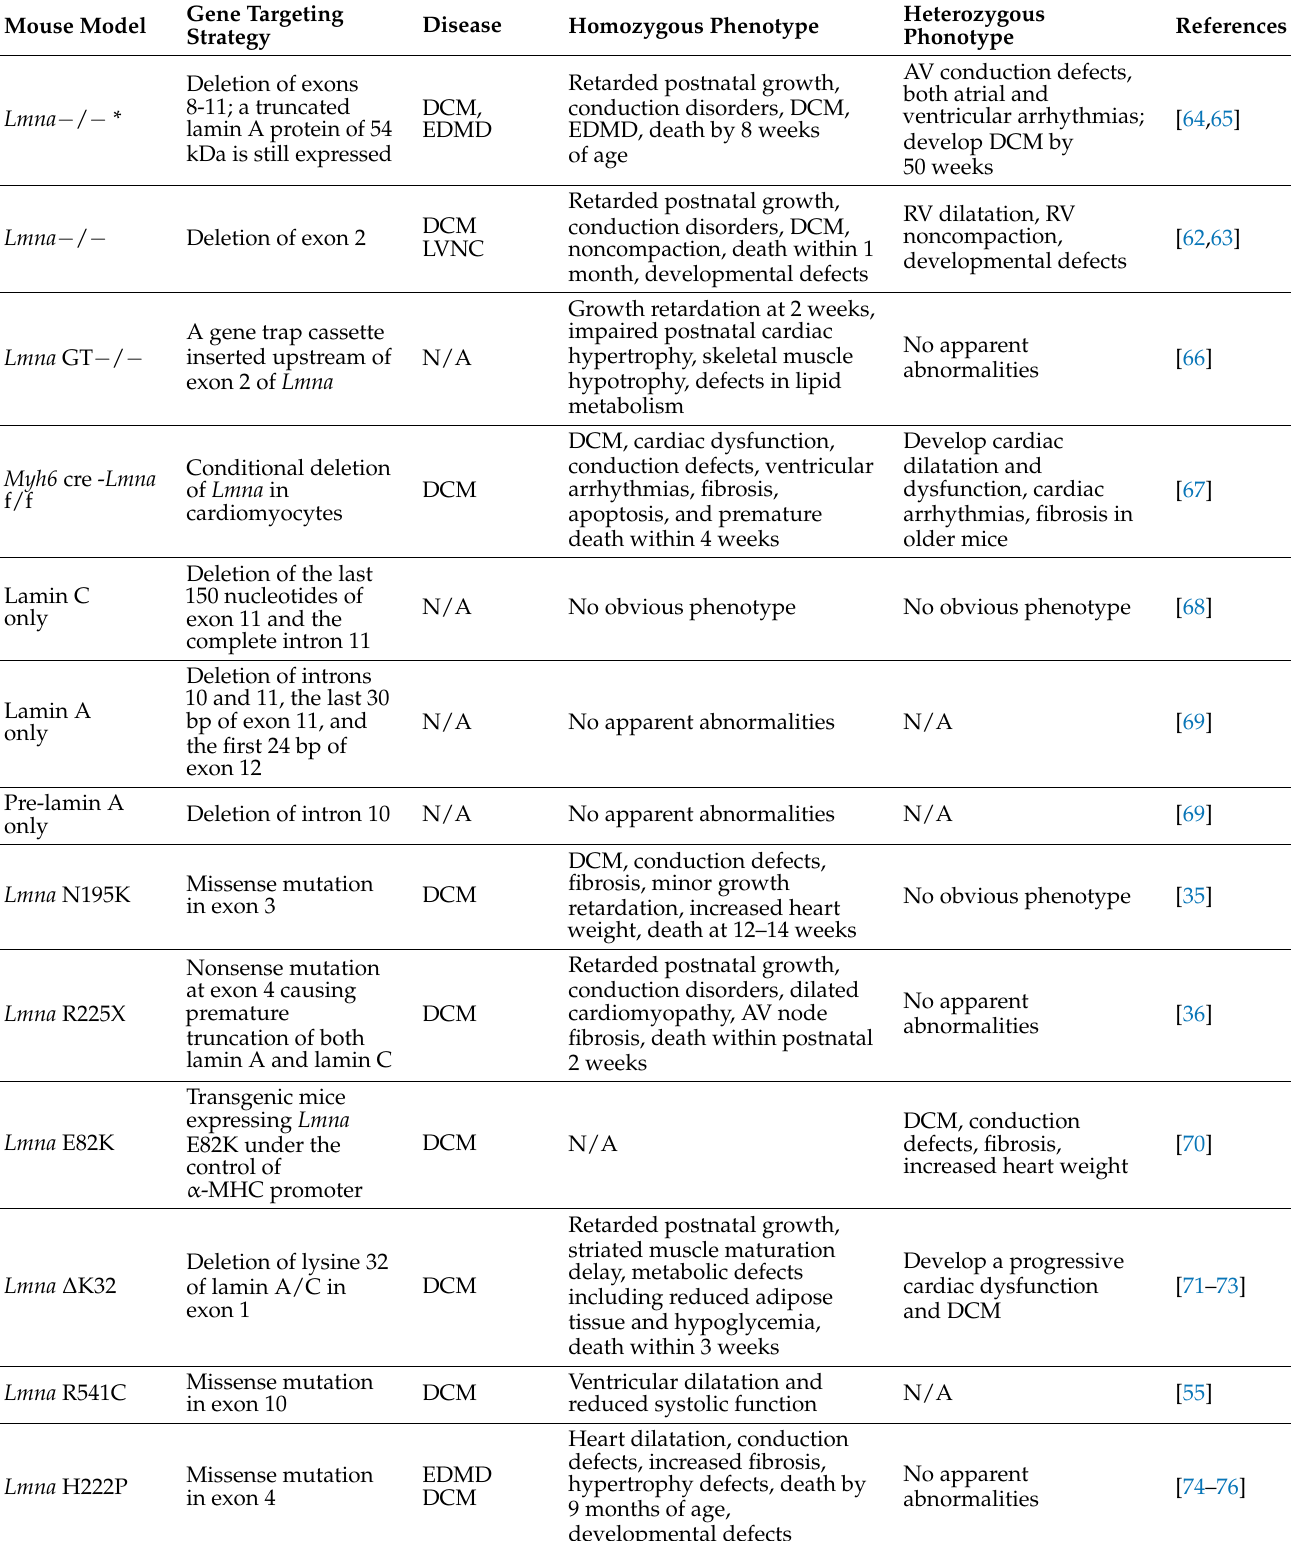
Table 2. Mouse models of